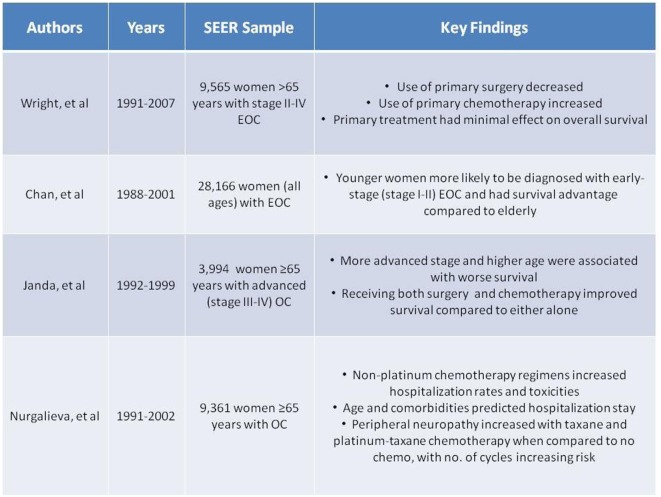
Summary of Selected Surveillance, Epidemiology and End Results (SEER) data (7, 10, 12, 54, 55).